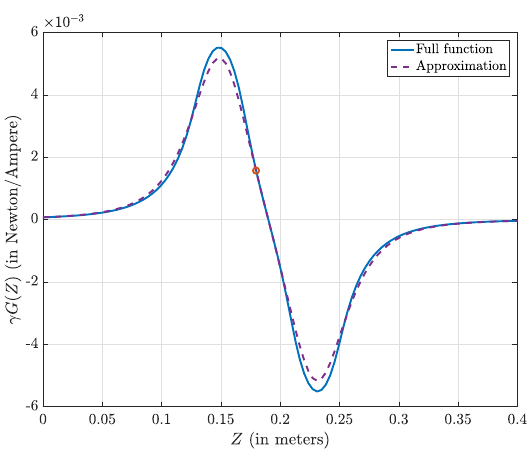
Fig. 3. Function G ( Z ) (defined in (5)) and its approximation G approx ( Z ) in the far field of the magnet (defined in (6)). The circle denotes the value G ( ¯ Z ) at the rest position ¯ Z = 0 . 18 . The values used for the rest of the parameters are taken from the table found in the appendix of